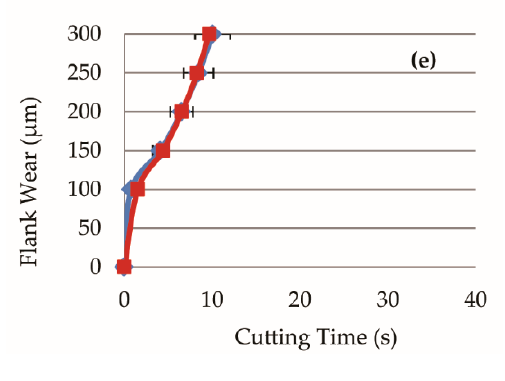
Figure 9. Predicted tool life in comparison with experimental results.